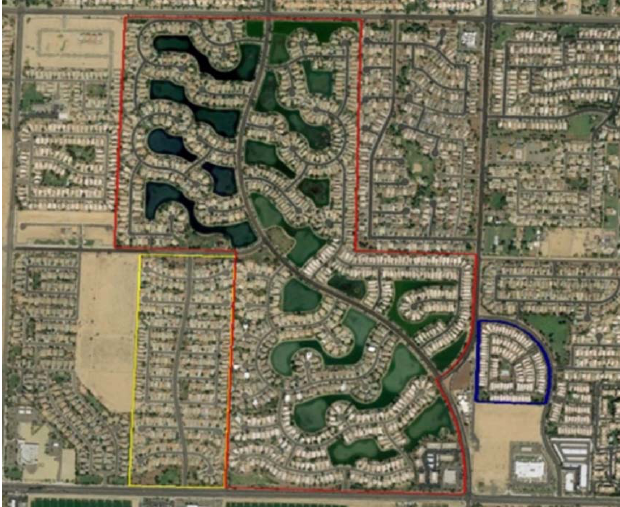
Figure 1. Crystal Gardens (red), Crystal Point (yellow), Sunrise at Harbor Shores (blue). Source: Google Earth .